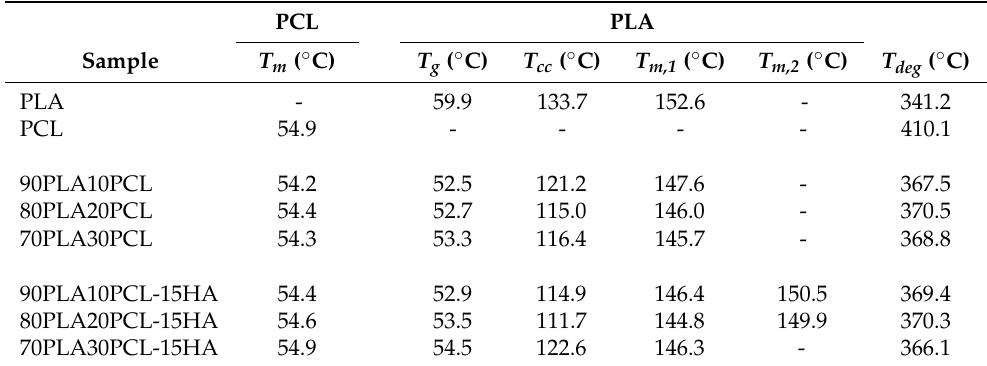
Table 3. Differential scanning calorimetry (DSC) results obtained from the second heating scan and degradation temperature from TGA.